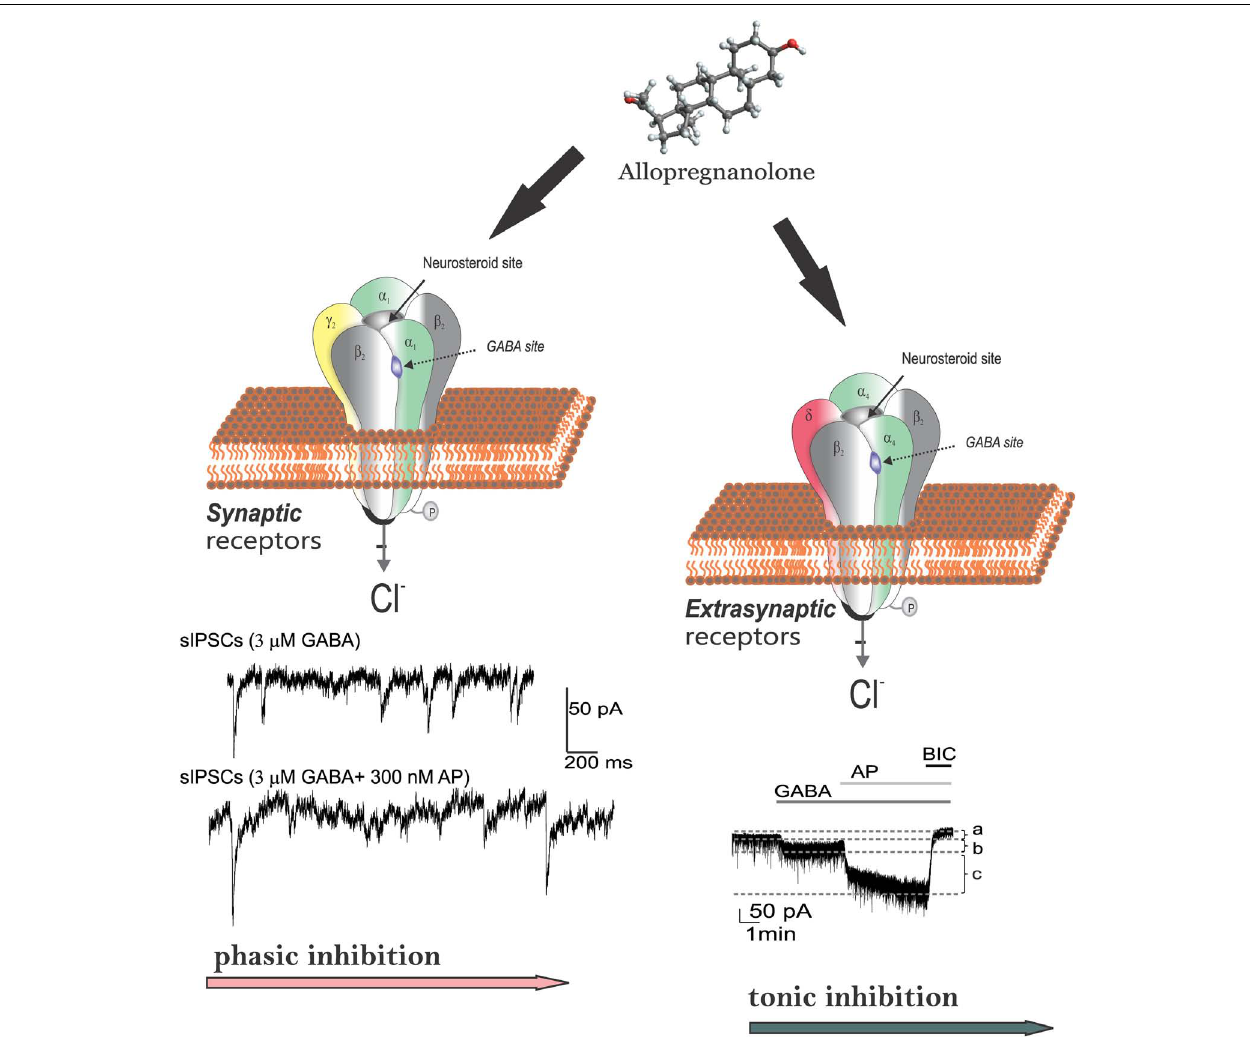
FIGURE 3 | Neurosteroid modulation of GABA-A receptors in the brain. Allopregnanolone and related neurosteroids binds and enhances GABA-A receptor-mediated inhibition in the brain. GABA-A receptors are pentameric with five protein subunits that form the chloride ion channel pore. Neurosteroids directly binds to the “neurosteroid binding sites” and potentiate the GABA-gated chloride currents.The neurosteroid binding sites are distinct from sites for GABA, benzodiazepines, and barbiturates.There are two types